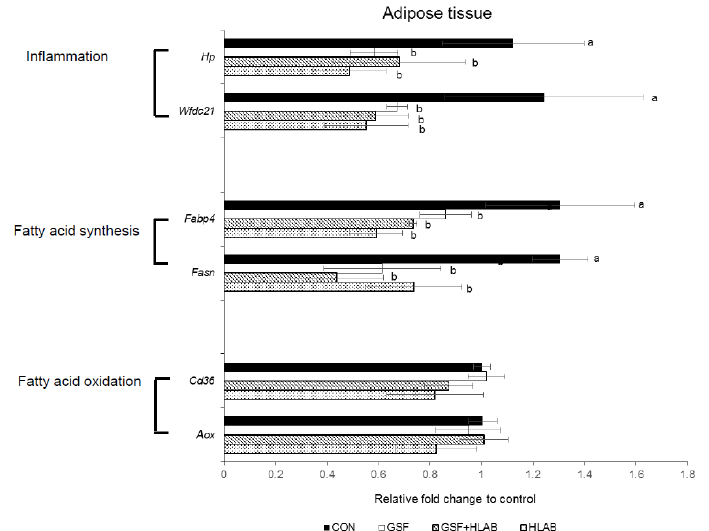
Figure 2. Effect of 2.5% wine grape seed flour (GSF) and heat-killed kefir lactic acid bacteria (HLAB) on gene expression levels in the adipose tissues of mice fed a high-fat and high-fructose diet (HFFrD) containing 5% microcrystalline cellulose (CON), 2.5% wine grape seed flour (GSF), 2.5% GSF with orally administered heat-killed kefir lactic acid bacteria (GSF+HLAB), and orally administered heat-killed kefir LAB (HLAB) for 8 weeks. Data are expressed as mean ± SE; n = 6/group. Values not sharing a common letter differed significantly at p < 0.05.